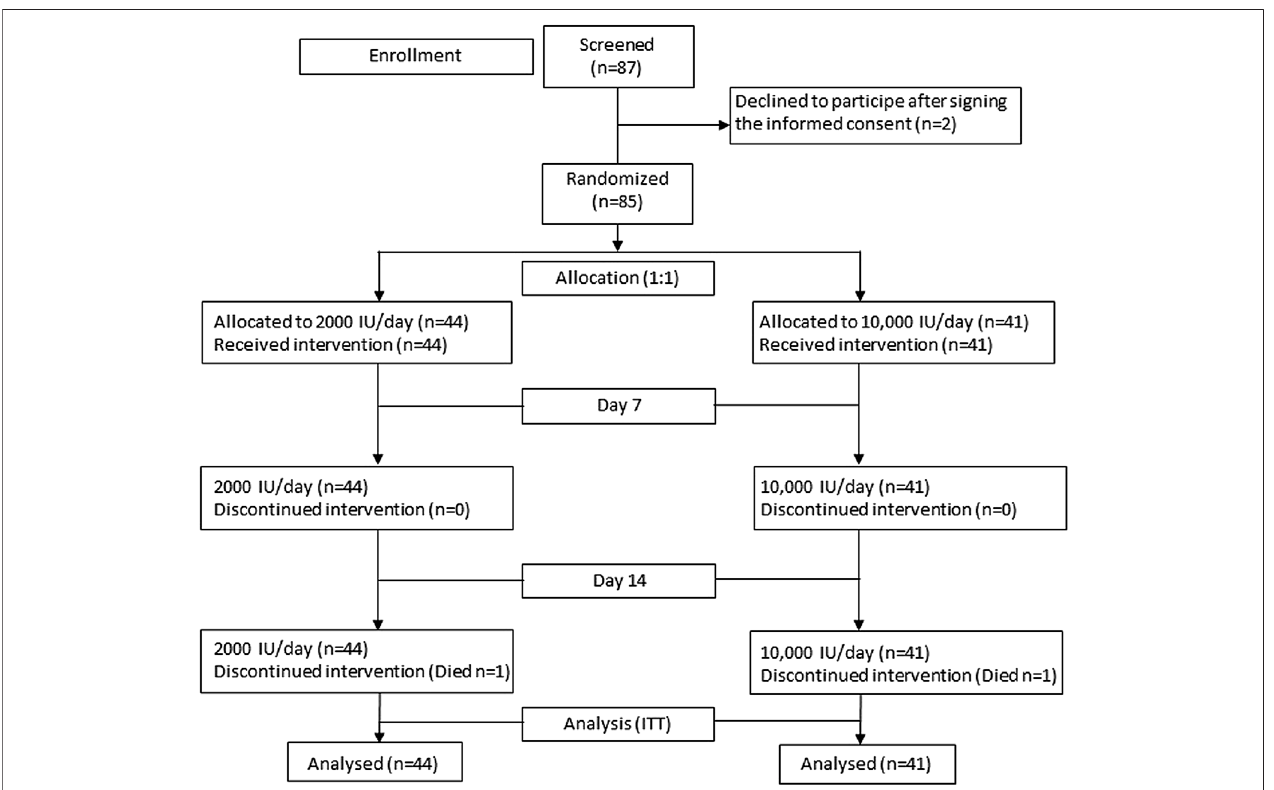
FIGURE 1 | Flowchart of the study design. ITT: intention to